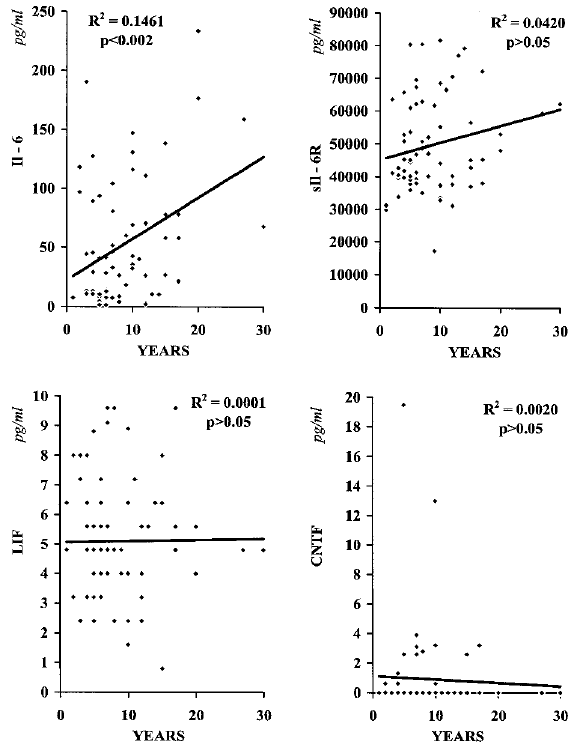
FIG. 2. Correlation between serum concentrations of IL-6, sIL- 6R, LIF and CNTF with duration of disease.